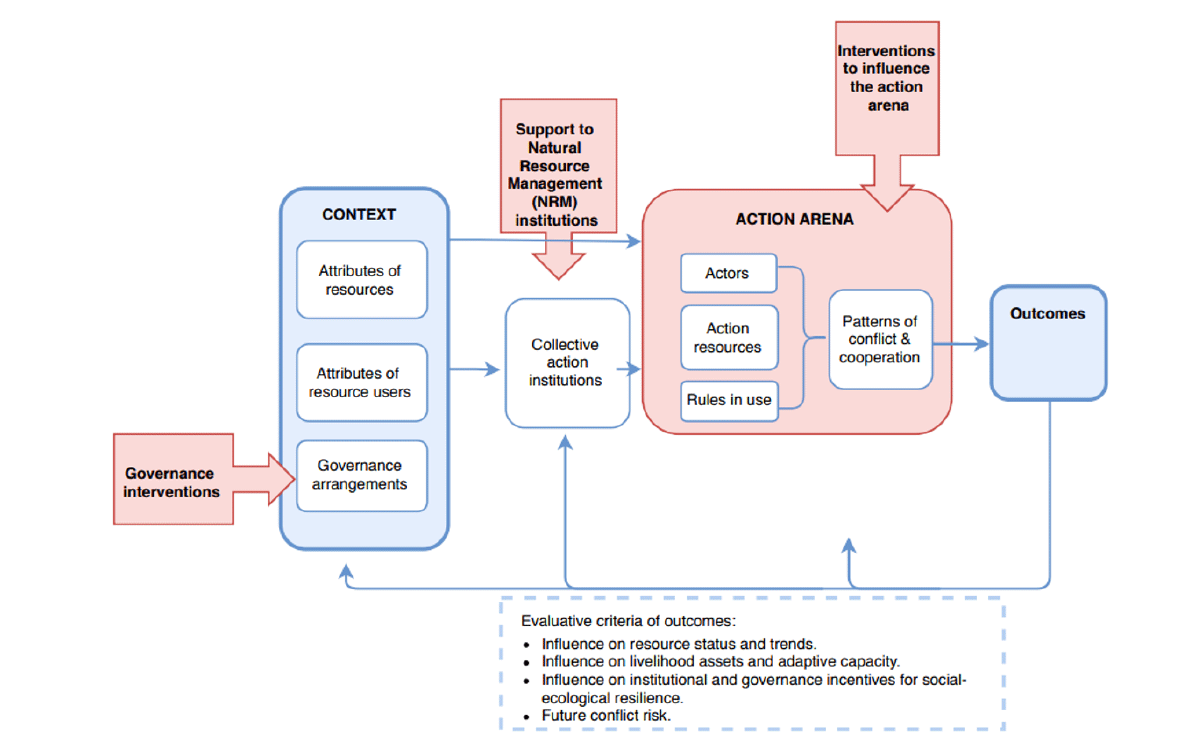
Fig. 1 . Framework for analysis of conflict and cooperation in natural resources management, showing three windows for intervention. Source: Ratner et al.